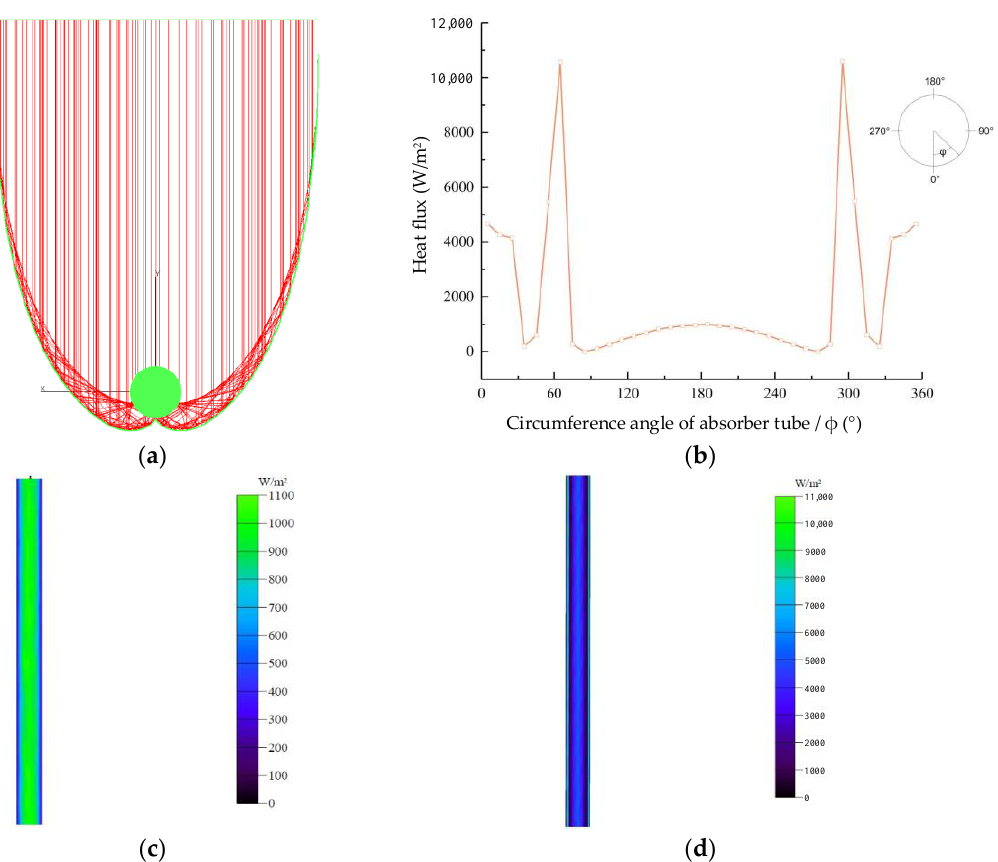
Figure 8. ( a ) CPC solar ray tracing results, ( b ) average circumferential solar radiation at the cross- section, ( c ) upper surface solar radiation distribution along the radial direction, ( d ) lower surface solar radiation distribution along the radial direction.